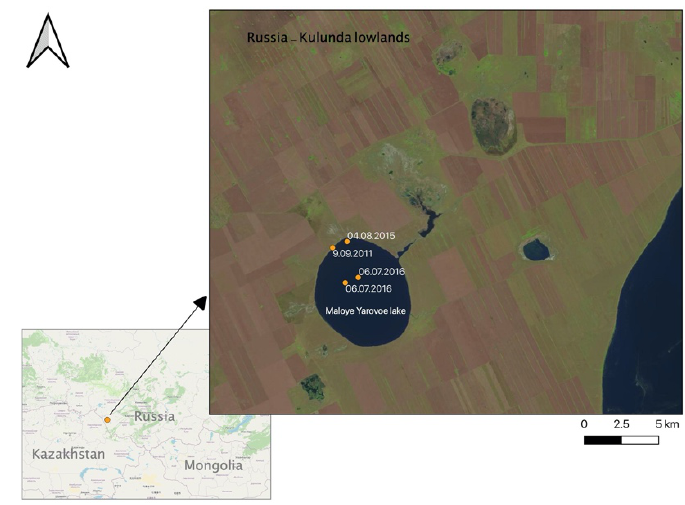
Figure 1. The location of Maloye Yarovoe lake (Kulunda lowland, Russia) with samples locations (data sources: Landsat-8 satellite image from EarthExplorer.usgs.gov with QGIS OSM Standard base map).